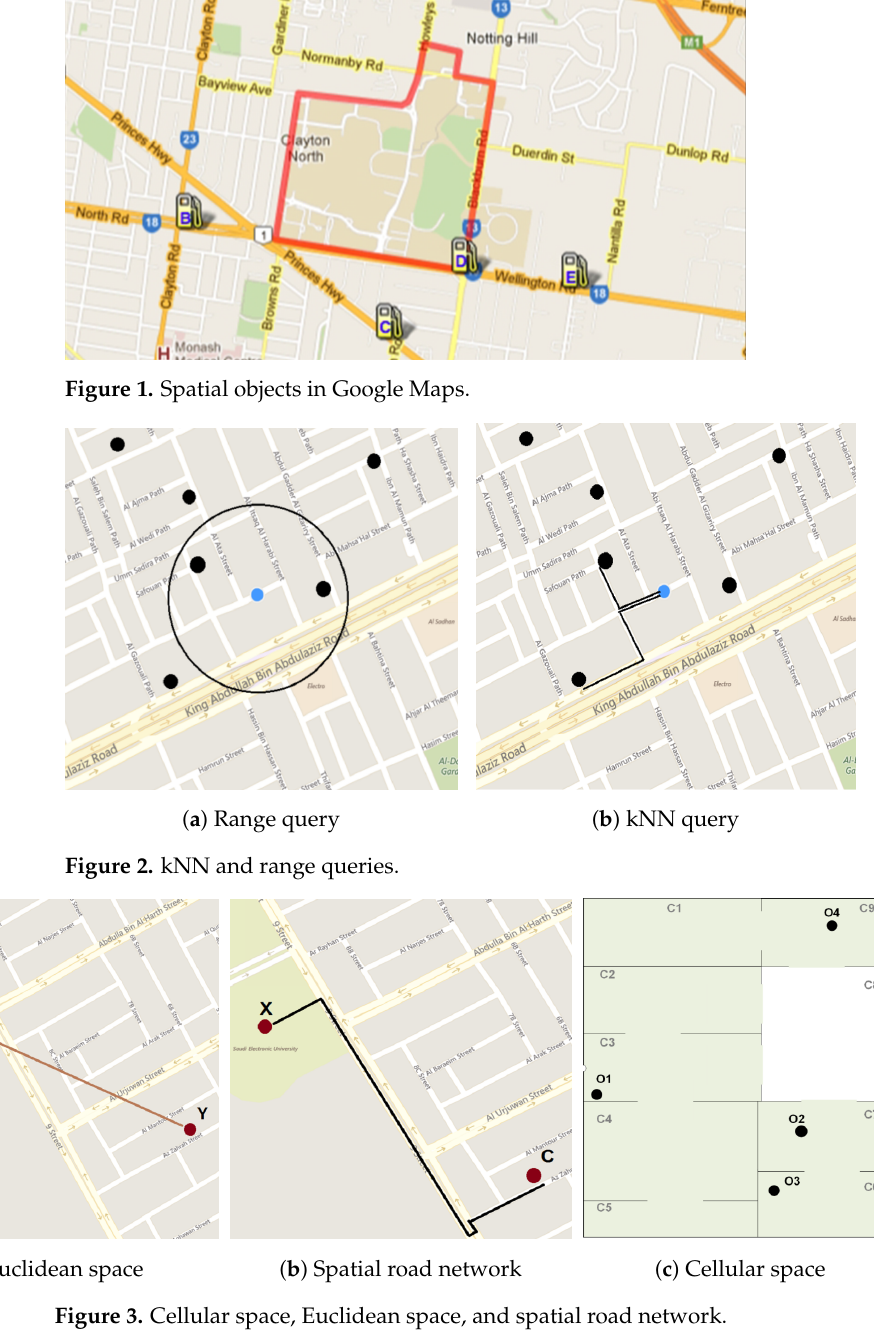
Figure 3. Cellular space, Euclidean space, and spatial road